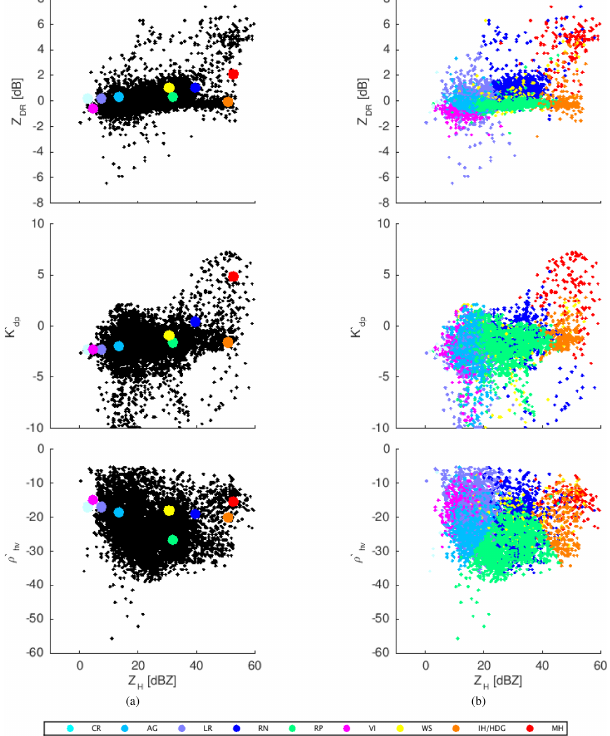
Figure 2. The multi-dimensional (four out of five dimensions) space: (a) target vectors representing centroids (larger points with different classes depicted by different colors) and observations (smaller black points), (b) observations with assigned labels. Ab- breviations: CRs – crystals; AGs – aggregates; LR – light rain;